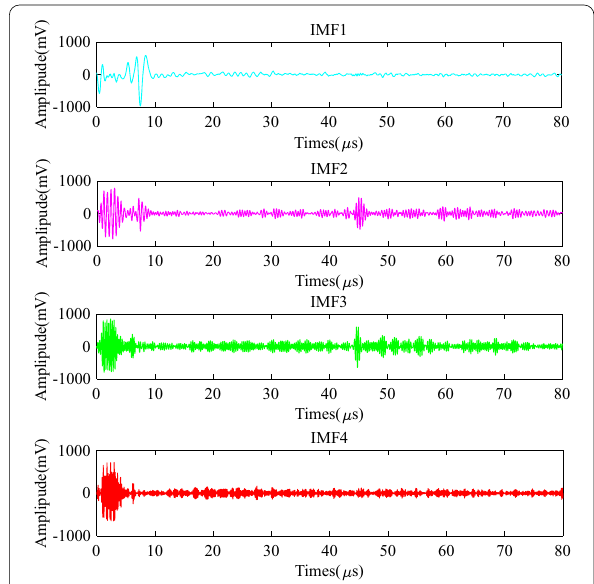
Figure 8 Signal after VMD decomposition in the time